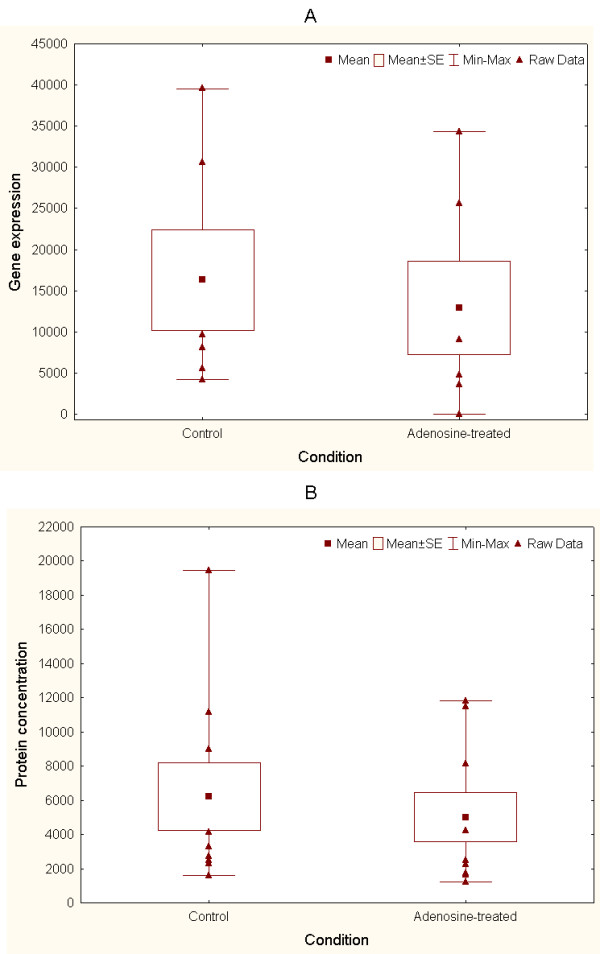
Comparison of CCL18 gene and protein expression values in treated vs. control samples. A: Gene expression values from Ado-treated and control samples (6 vs. 6 experiments, fold-change = 0.87, Mann-Whitney U test, P = 0.42). B: Protein concentration values from matched Ado-treated and control experiments (9 vs. 9 experiments), fold-change = 0.83, Wilcoxon matched-pairs test, P = 0.066)